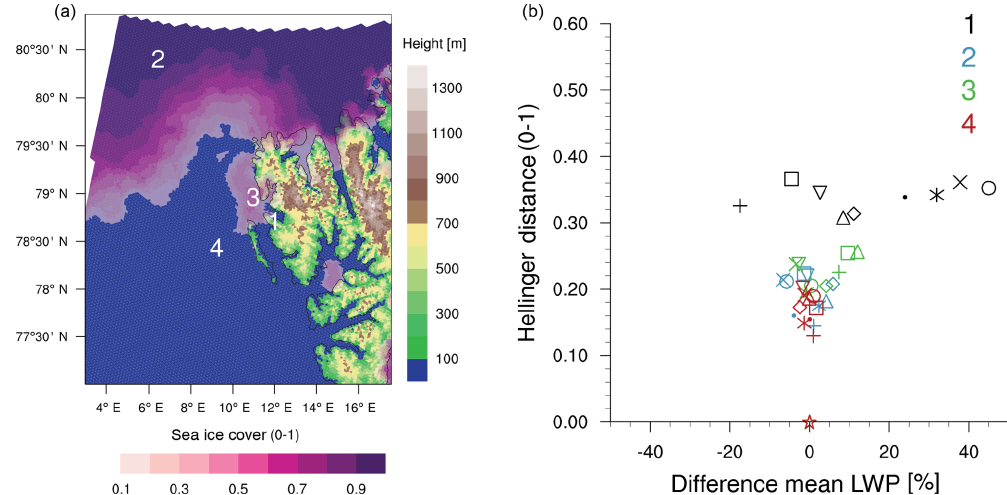
Figure 9. (a) Location of the four 10-grid-point subregions used for the representativity analysis: land (1), sea ice (2), mixed conditions (sea ice and open water, 3) and open water (4). (b) The Hellinger distance and differences in the mean LWP of the LWP PDFs of the surrounding grid points (different symbols) compared to the central point (star symbol) of the four subregions (overlaid). Values have been calculated for each day and then averaged over all